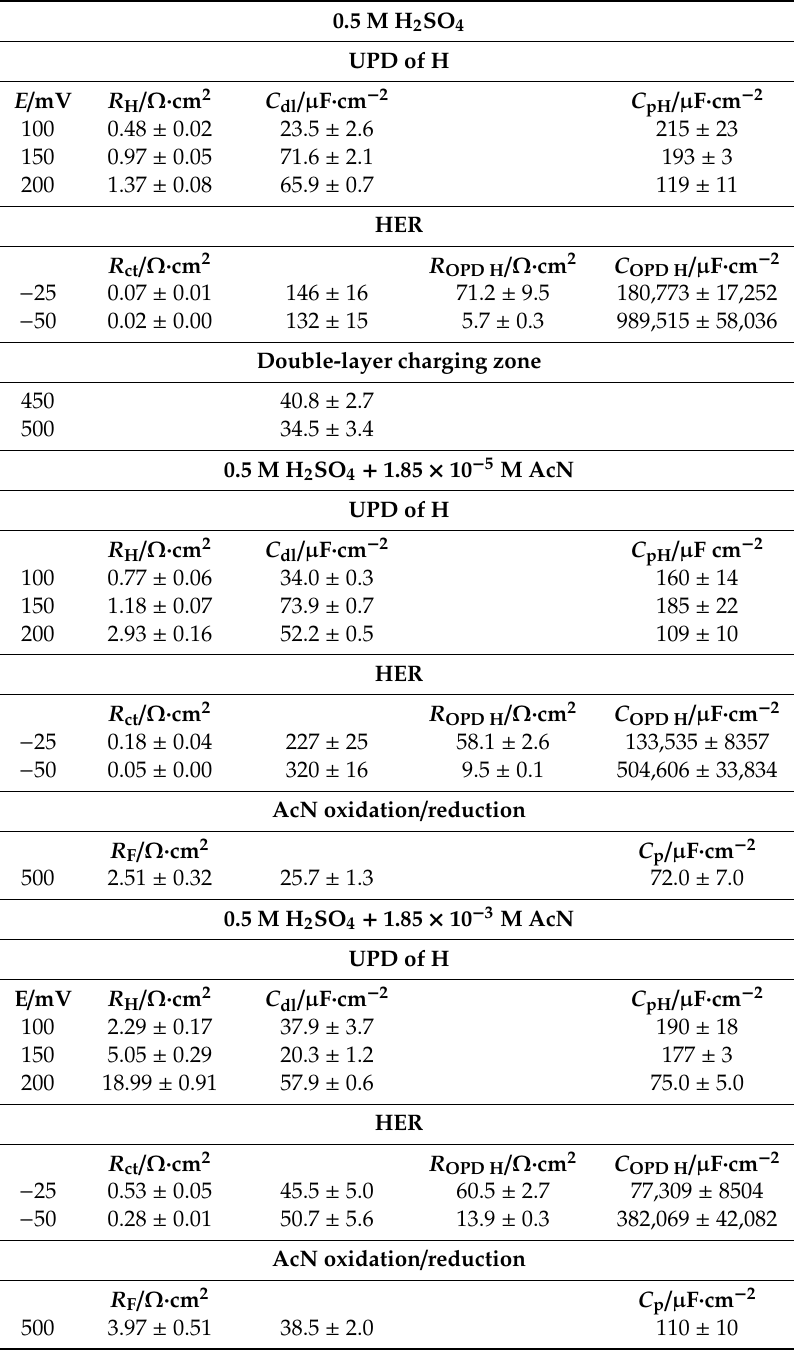
Table 1. Resistance and capacitance parameters for UPD of H, HER and AcN reversible oxidation / reduction processes on polycrystalline Pt electrode surface in contact with 0.5 M H 2 SO 4 and in the presence of acetonitrile (at 293 K), obtained by fitting the equivalent circuits shown in Figure 3a through Figure 3c to the recorded impedance data (recorded values of dimensionless ϕ parameters for the CPE circuit components oscillated between 0.81–0.99 and 0.97–0.99 for UPD of H; impedance reproducibility usually below 10%; χ 2 = 9 × 10 − 5 to 4 × 10 − 4